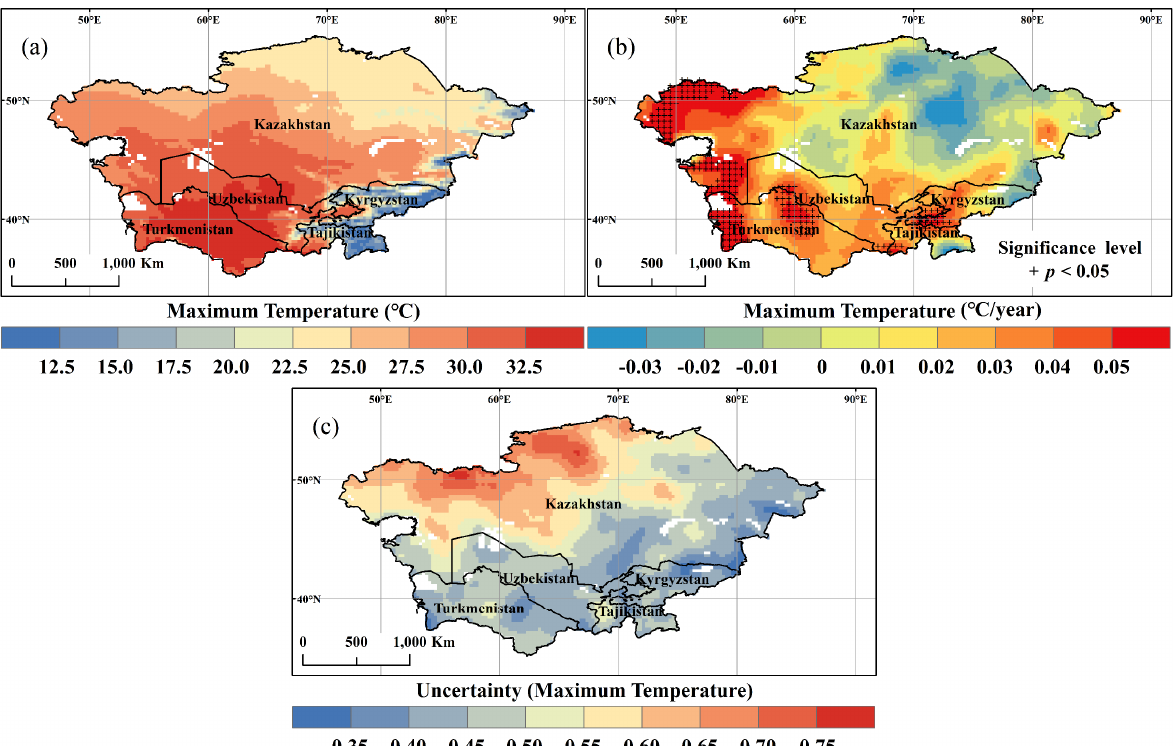
Figure 4. Spatial distribution of ( a ) the annual means for maximum temperature, ( b ) the trend for maximum temperature, and ( c ) the uncertainty in the trend of maximum temperature in the study area from 1982–2014.